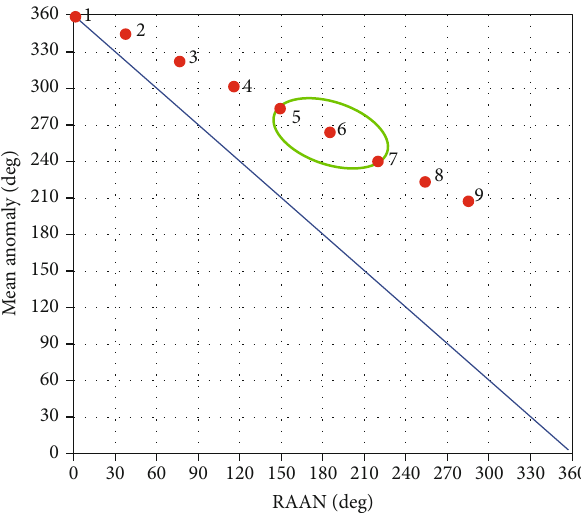
Figure 10: Results for 9 COB satellites.